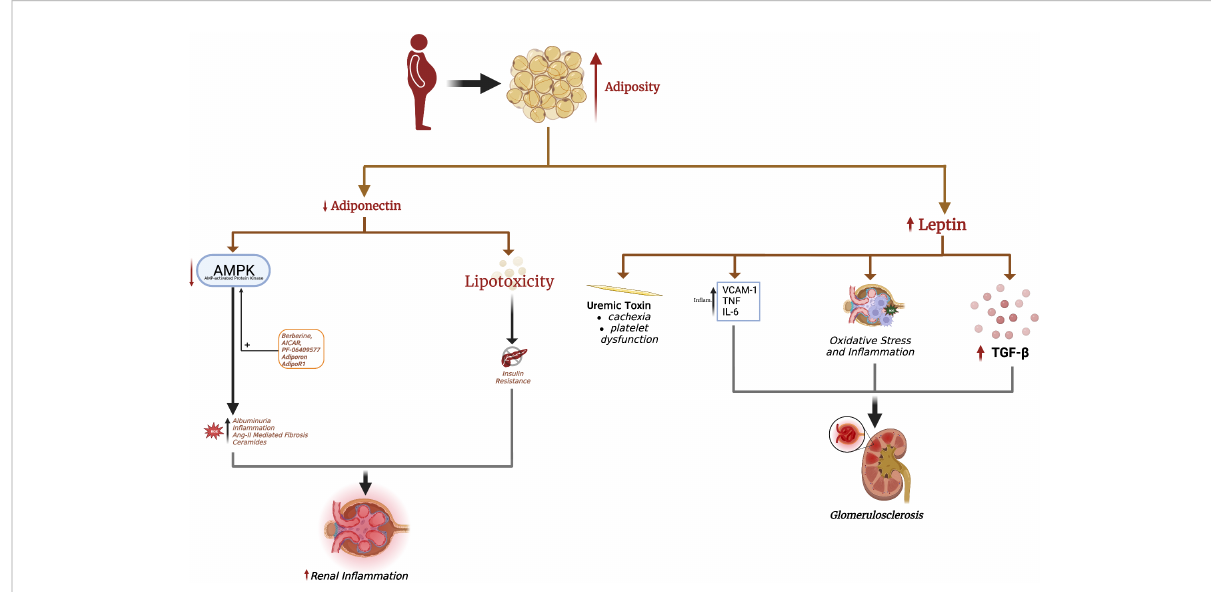
FIGURE 1 Excess adiposity increases serum leptin and decreases adiponectin. Hyperleptinemia promotes renal fi brosis, leading to glomerulosclerosis seen in obesity-induced glomerulopathy. Leptin is also considered a uremic toxin, contributing to uremic cachexia and platelet dysfunction. The decrease in renal adiponectin effect in obesity is causal in the development of albuminuria. Loss of adiponectin effect in obesity also increases renal oxidative stress, fi brosis, and in fl ammation. Adiponectin-mediated AMPK activation is responsible for many of adiponectin's renoprotective effects, with a decrease in AMPK implicated in albuminuria and renal injury. The adiponectin receptor agonist AdipoRon and direct AMPK activators AICAR, berberine, and PF-06409577 are pharmacological strategies to increase renal AMPK levels and mitigate obesity-related kidney